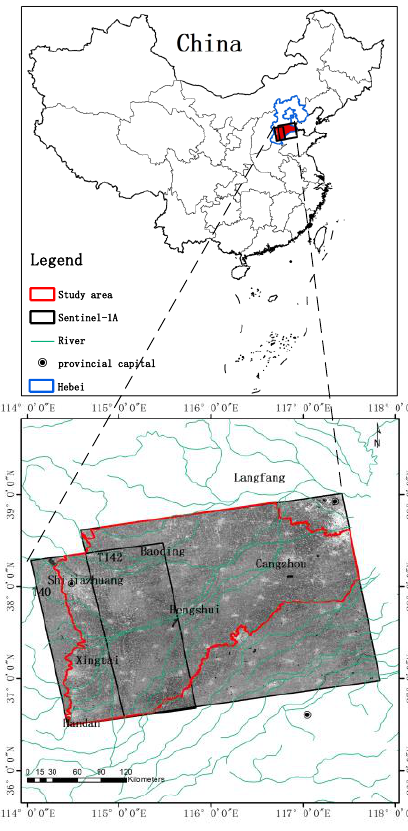
Figure 1. Location of the study area. The black border is the Sentinel-1A data range, the red border is the study